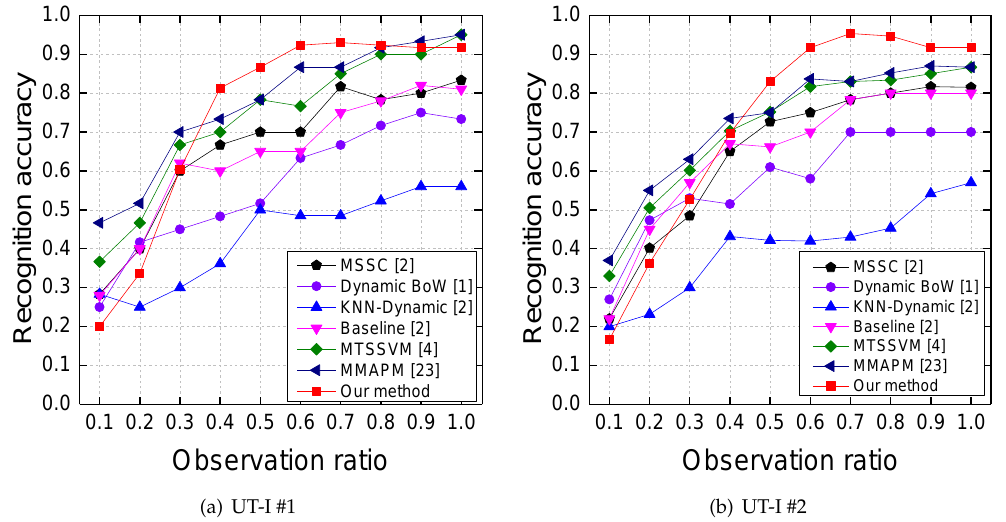
Figure 4. Prediction results on the UT-Interaction dataset.